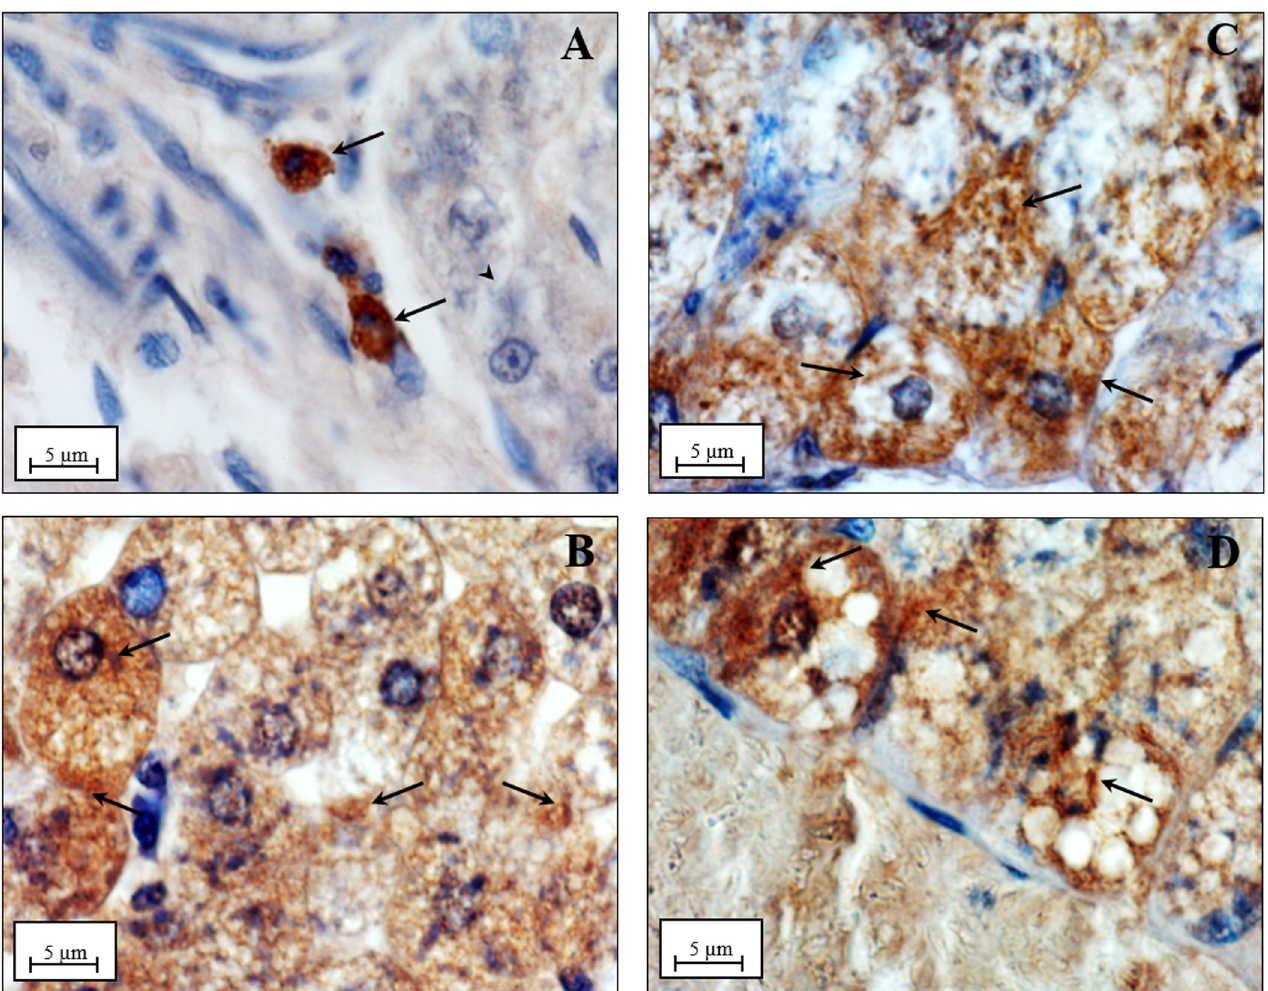
Fig 10. UCP2 Immunolocalization. (A) Under normal diet condition (N group), only phagocytic cells were marked with primary antibody (black arrows), whilst no positivity was detected in the hepatocytes (arrowhead). (C) Immunoreactive hepatocytes (black arrows) were evident following HFD condition and in DDE-treated groups (panel B, D group; panel D, D+DDE group). Notice mitochondria labeled by anti-UCP2 antibody, thus confirming the reliability of the immunostaining. Magnification used: 100X; Scale bar 5 μ m.